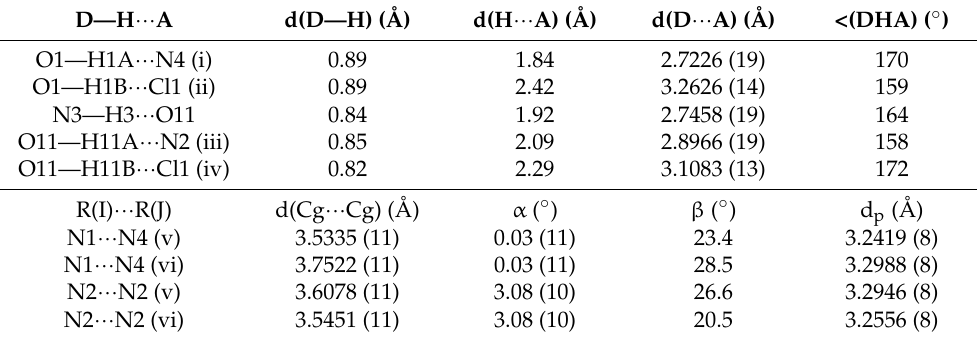
Figure 7. H-bond cyclic synthons in C1 .